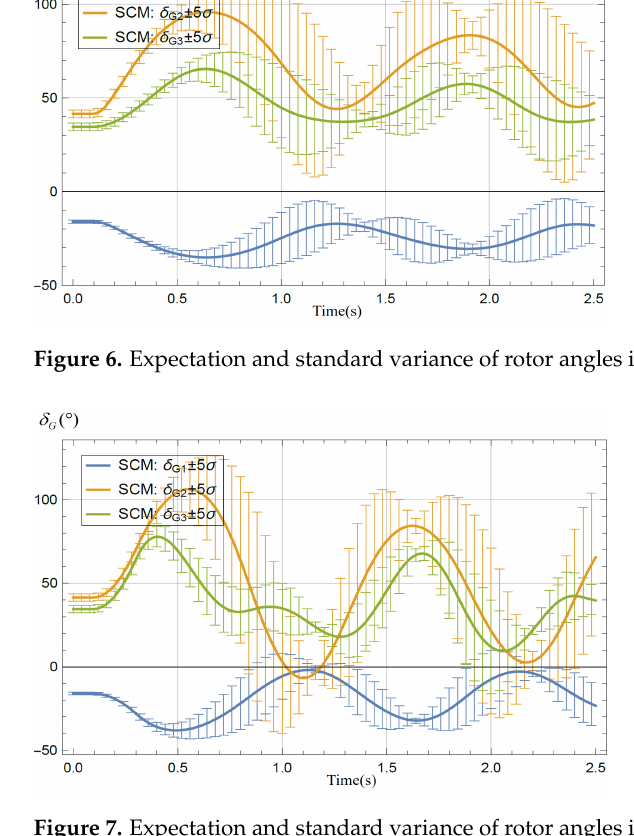
Figure 7. Expectation and standard variance of rotor angles in fault